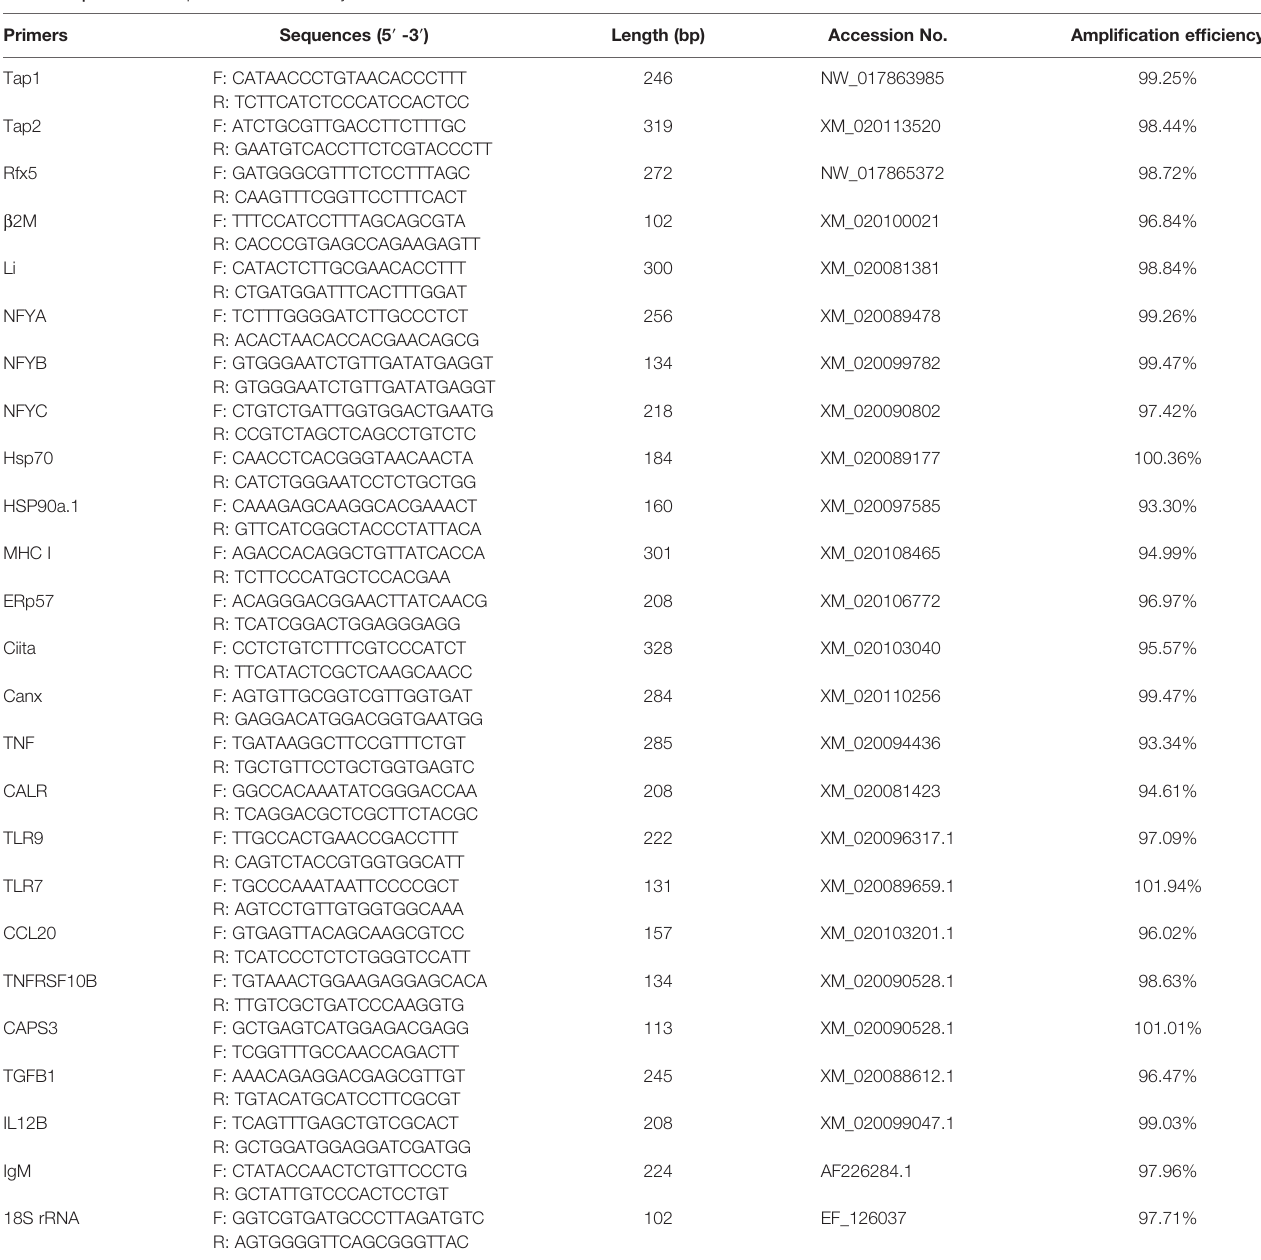
TABLE 1 | Primers for quantitative PCR